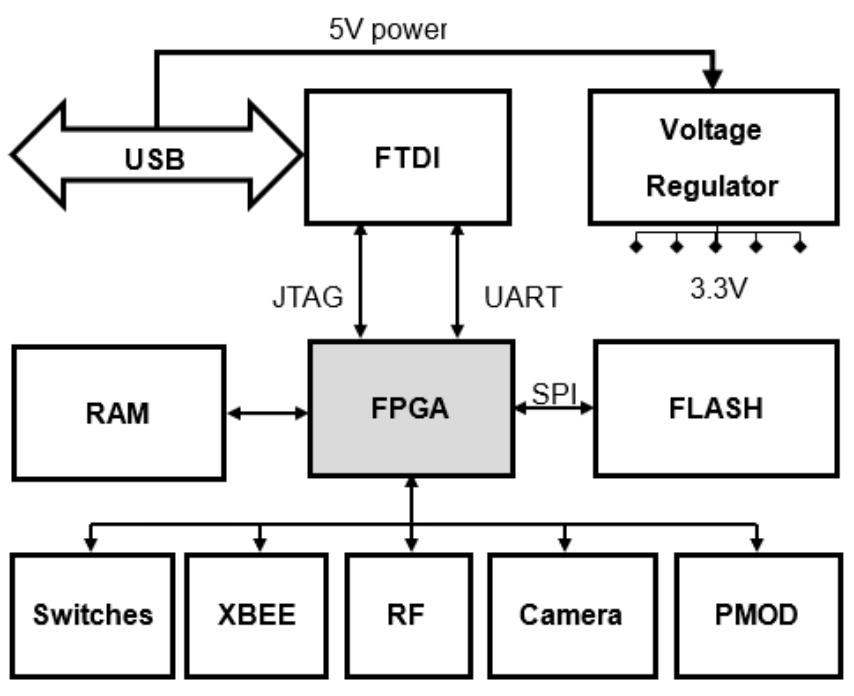
Figure 1. Block diagram of the Wireless Sensor Node. A photograph of the base sensor node (all peripheral modules removed) is shown in Figure 2.